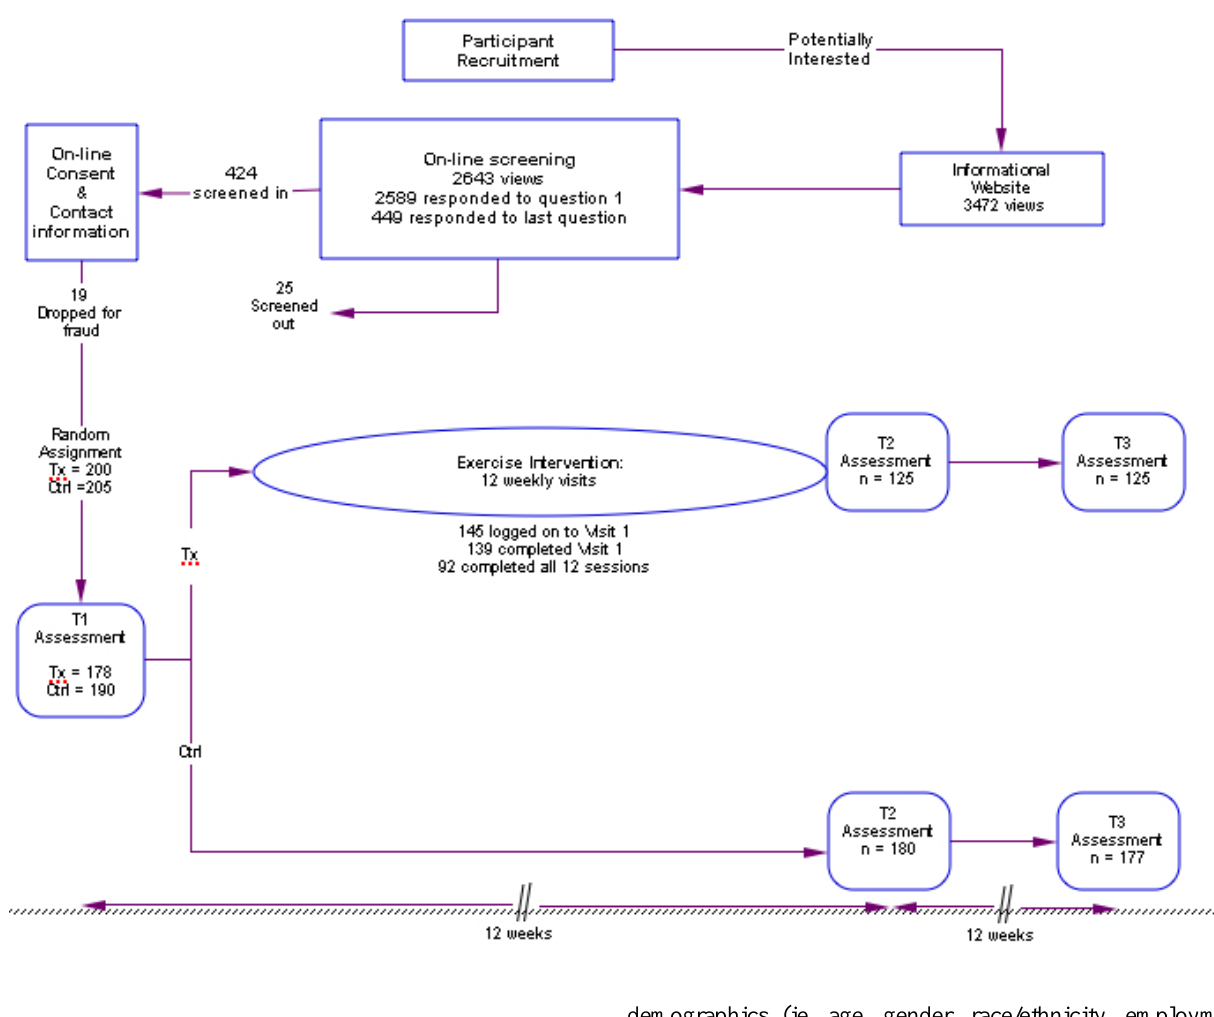
Figure 1. Research design with participation level from recruitment to T3